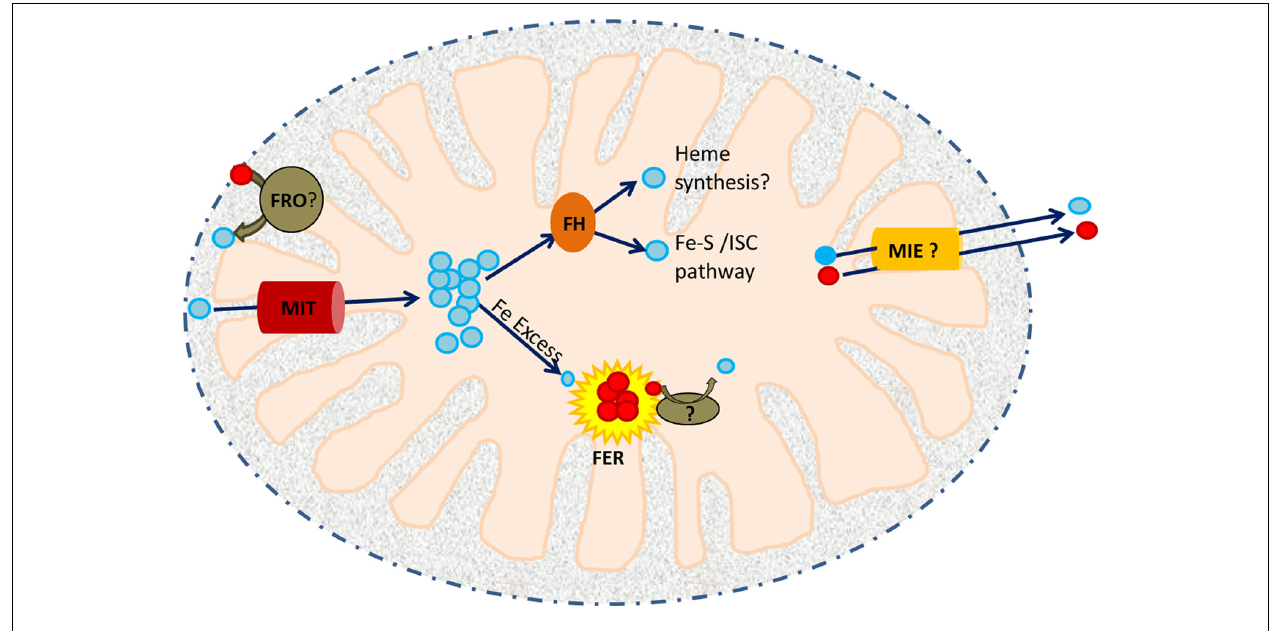
assembly proteins and possibly to the heme biosynthetic machinery. Excess Fe 2 + is stored in FER4. Iron released from FER4 upon Fe deficiency may require the activity of another reductase prior to its utilization/remobilization. Mitochondrial iron exporters (MIEs) are postulated to function in mitochondrial iron export for delivery of iron to